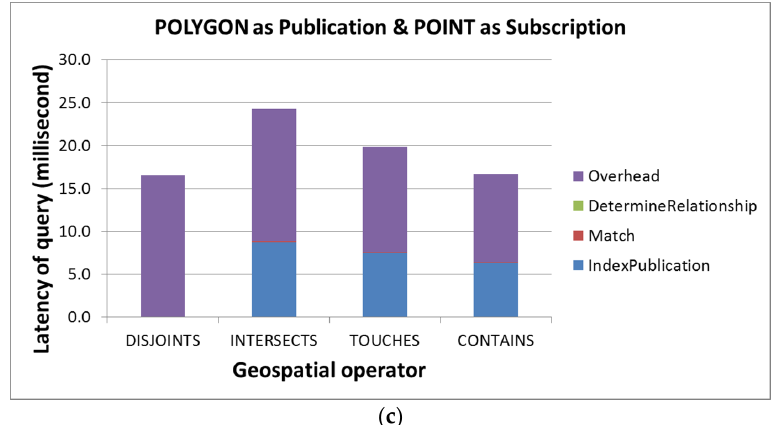
Figure 7. The end-to-end query performance for point as subscription and ( a ) point; ( b ) line; and ( c ) polygon geometry as publication.